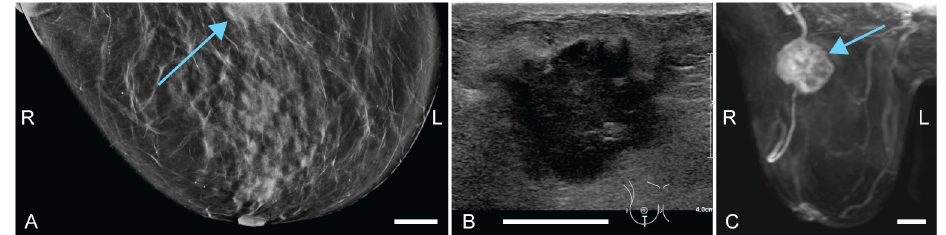
Fig 5. Case 2: Diagnostic images of an invasive carcinoma in the right breast. L and R indicate left and right, respectively. (A) Craniocaudal x-ray (CC-MMG). (B) Ultrasound (US) image, where the lesion is clearly visible (C) Perfusion maximum intensity projection magnetic resonance (MR) image. All scale bars represent 20